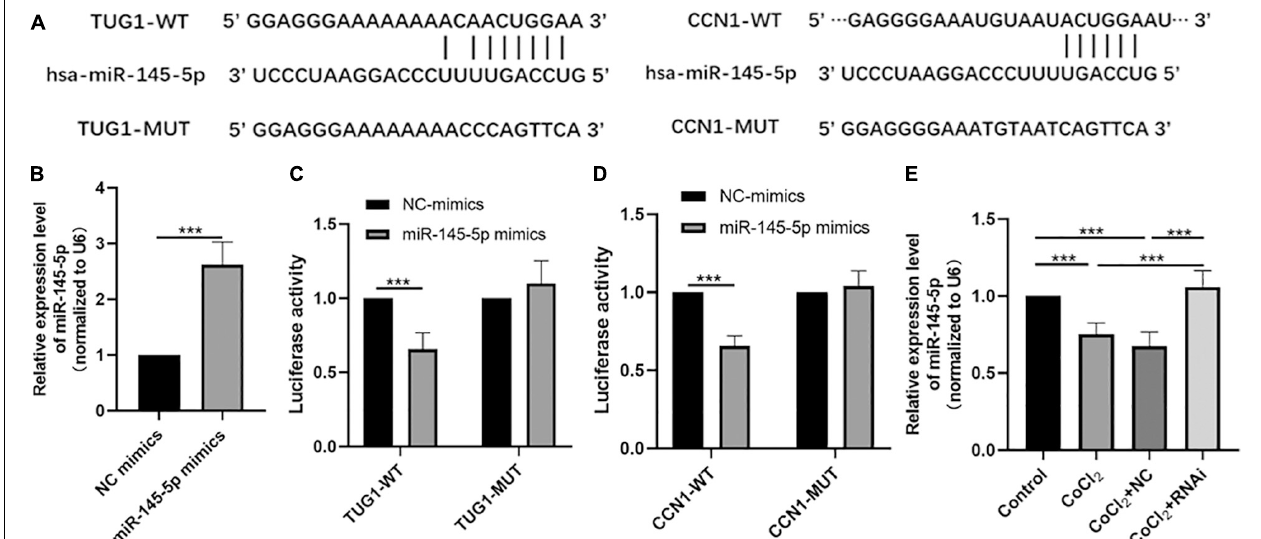
Frontiers in Medicine |